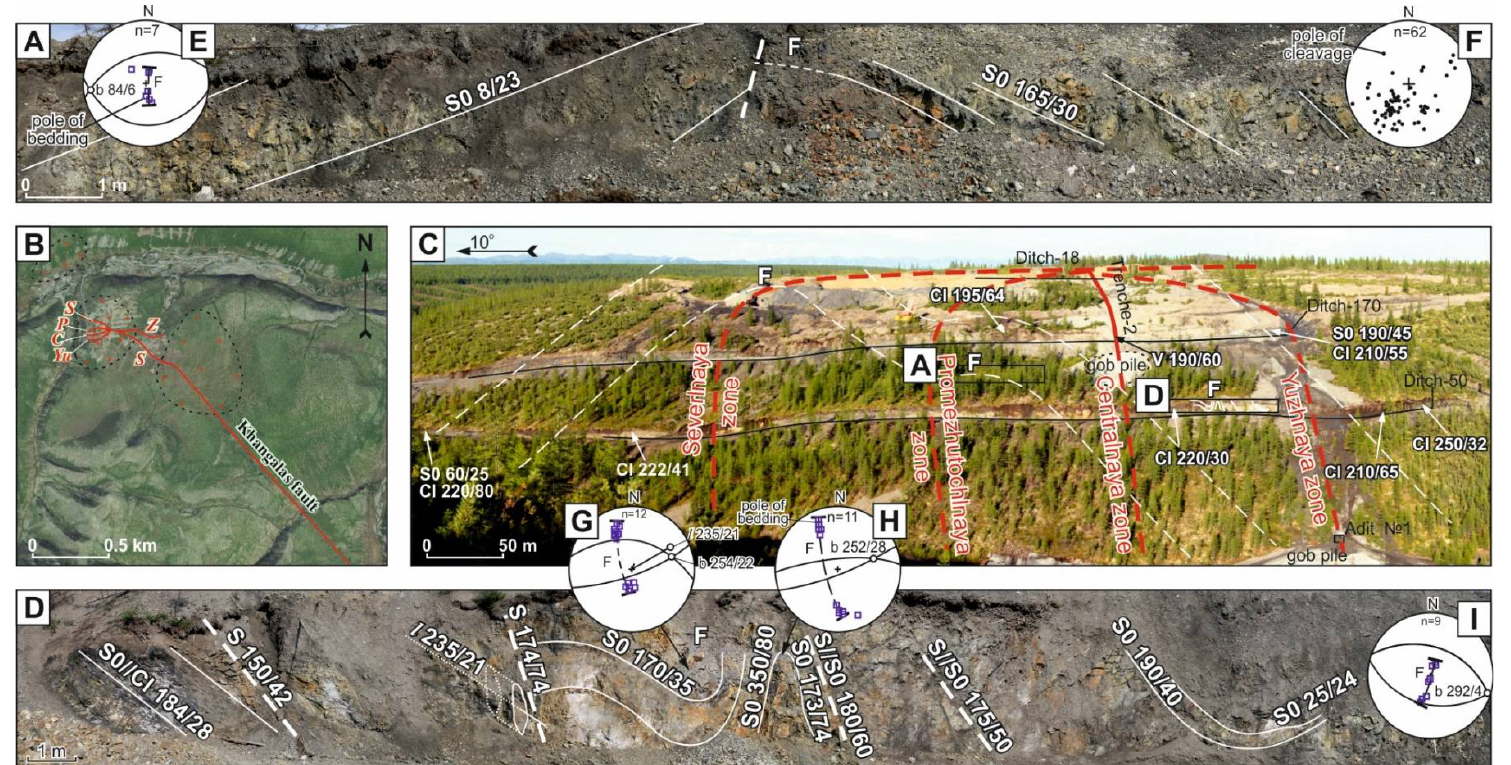
Figure 4. Bing Maps-satellite image ( B ), panoramic photo ( C ) and folds ( A , D ) of the Khangalas deposit. ( E – I ) Stereograms of bedding poles; Cl, cleavage. Mineralized fault zones: S, Severnaya; P, Promezhutochnaya; C, Centralnaya; Yu, Yuzhnaya; Z, Zimnyaya.